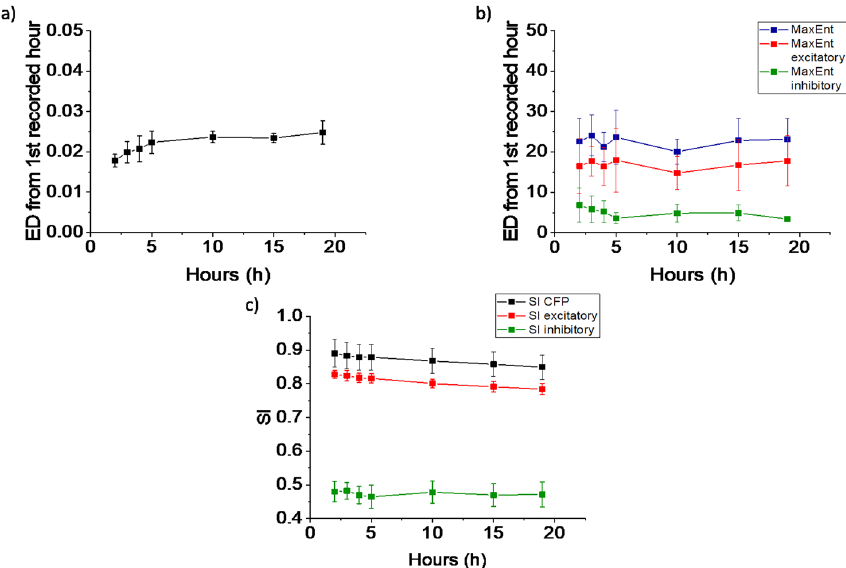
Figure 4. Inferred connectivity from spontaneous activity recordings using CFP or MaxEnt models during time. ( a ) CFP connectivity matrices were calculated for every hour of recording. Shown are mean Euclidean distances to the connectivity matrix of the first hour (n = 4 networks). CFP connections slowly drift away from the starting connectivity. ( b ) Same analysis as in ( a ) but with MaxEnt connectivity matrices, all connections (blue), excitatory connections only (red) and inhibitory connections only (green). Results show a similar trend as for CFP connectivity ( c ) Similarity indices (SI) of excitatory (red) and inhibitory (green) connections of MaxEnt connectivity matrices, and similarity indices of CFP connectivity matrices (black). around 85% of CFP connections (mainly excitatory) and 80% of MaxEnt excitatory connections remained unchanged. On the other hand around 50% of MaxEnt inhibitory connections seemed to not change during long recordings. Error bars indicate SEM, and refer to differences between networks.